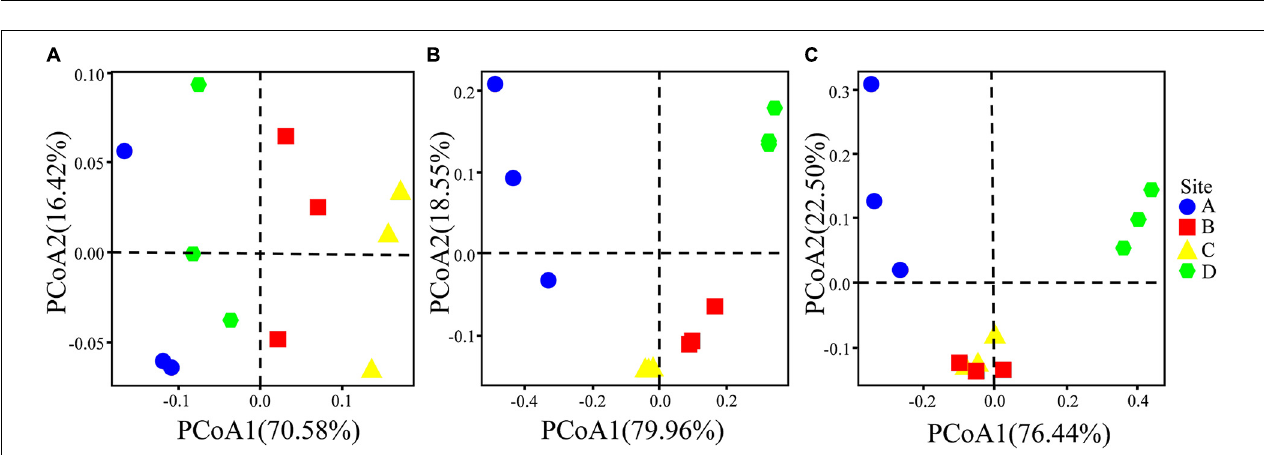
FIGURE 3 | PCoA plots depicting (A) the physicochemical properties of the soils and (B) total heavy metals/metalloids in the soils, and (C) the available heavy metals/metalloids in the soils based on the Bray–Curtis distances at the sampling